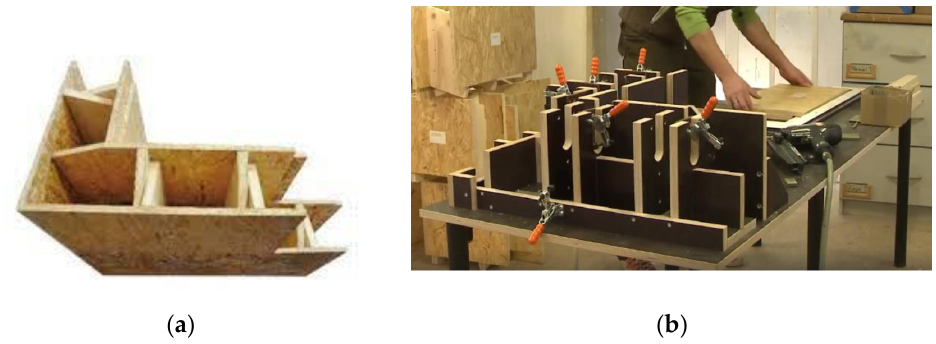
Figure 3. LUXHOME [7]. ( a ) corner element and ( b ) product assembly.